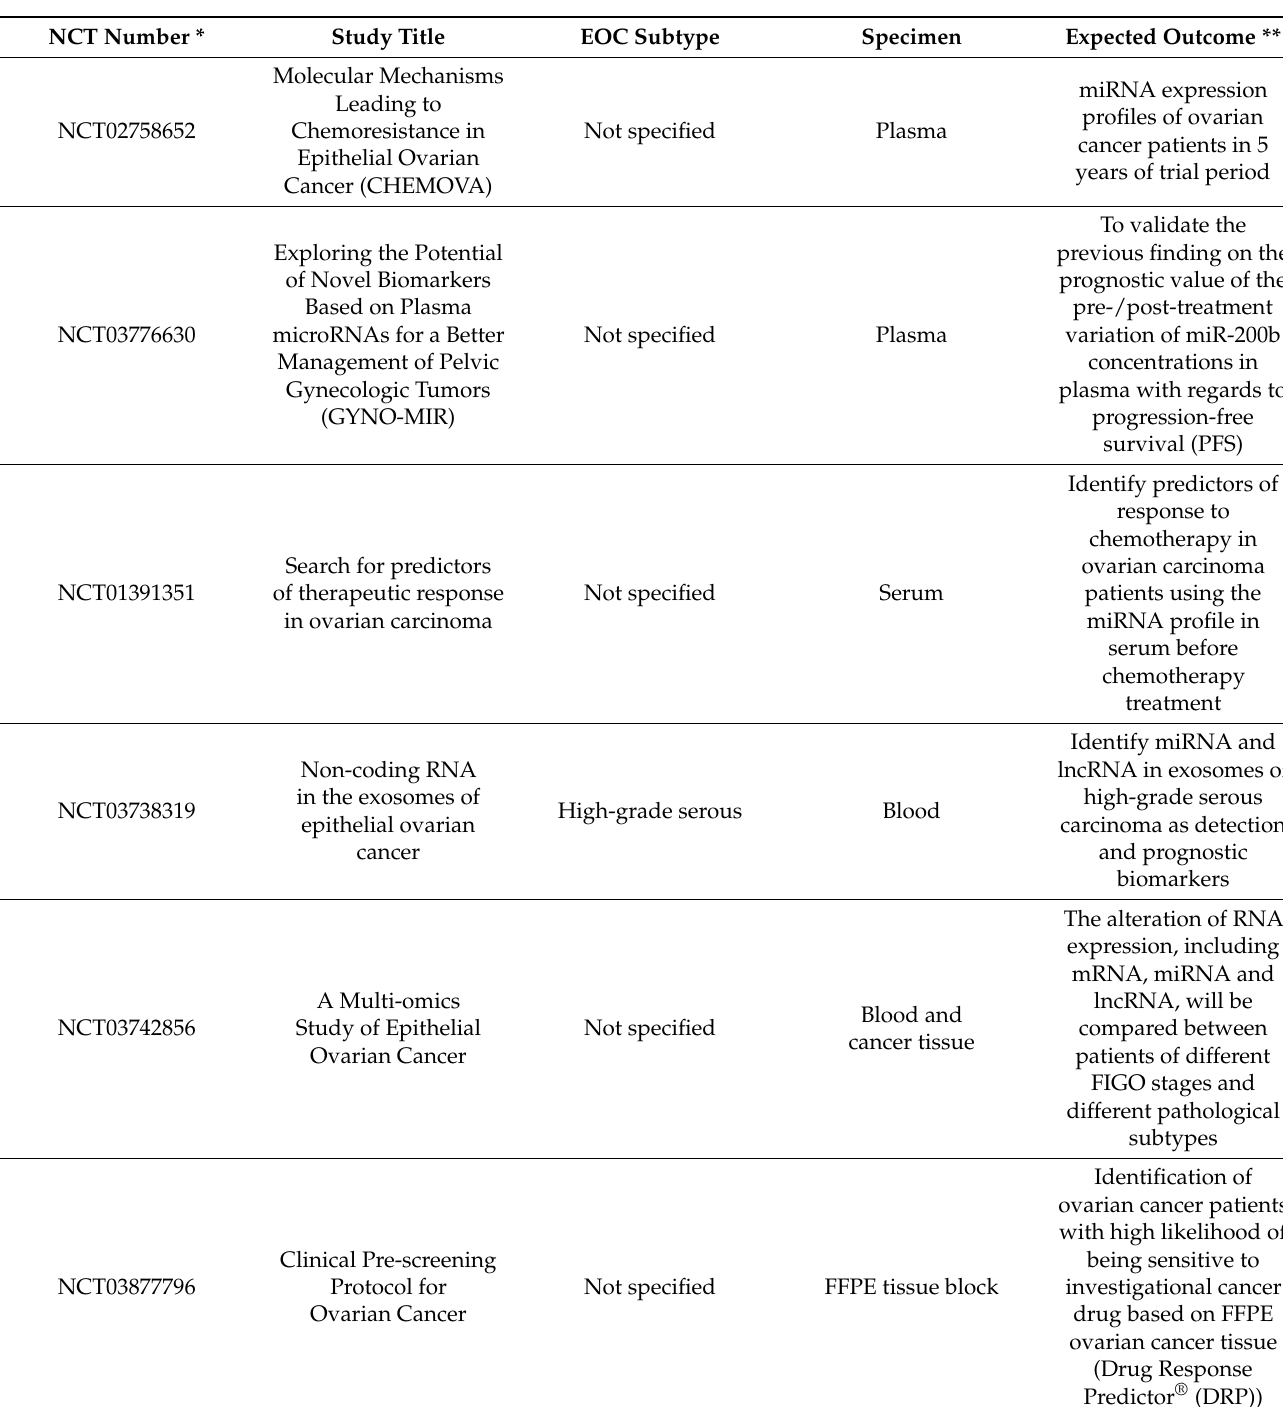
Table 4. Summary of current clinical trials related to epithelial ovarian cancer that use miRNAs in the circulatory system or tissues as biomarkers. FIGO: Federation of Gynecology and